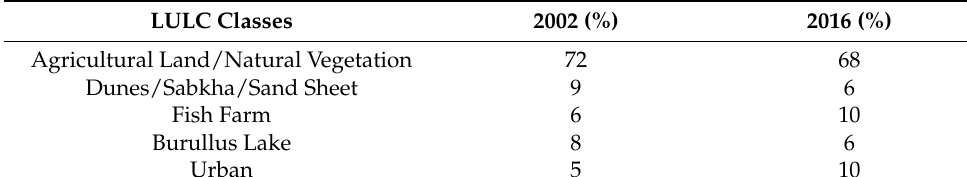
Table 4. The percentage of area coverage for LULC classes in 2002 and 2016.